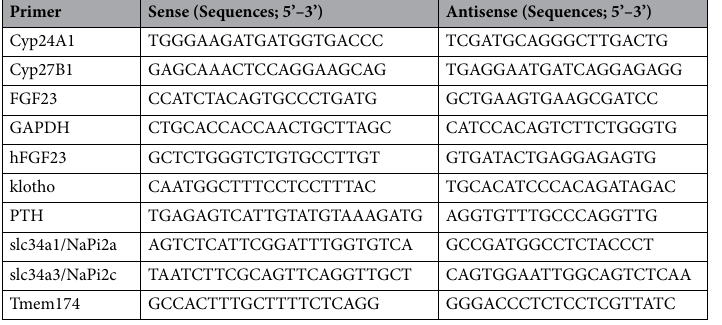
Table 2. Primers for